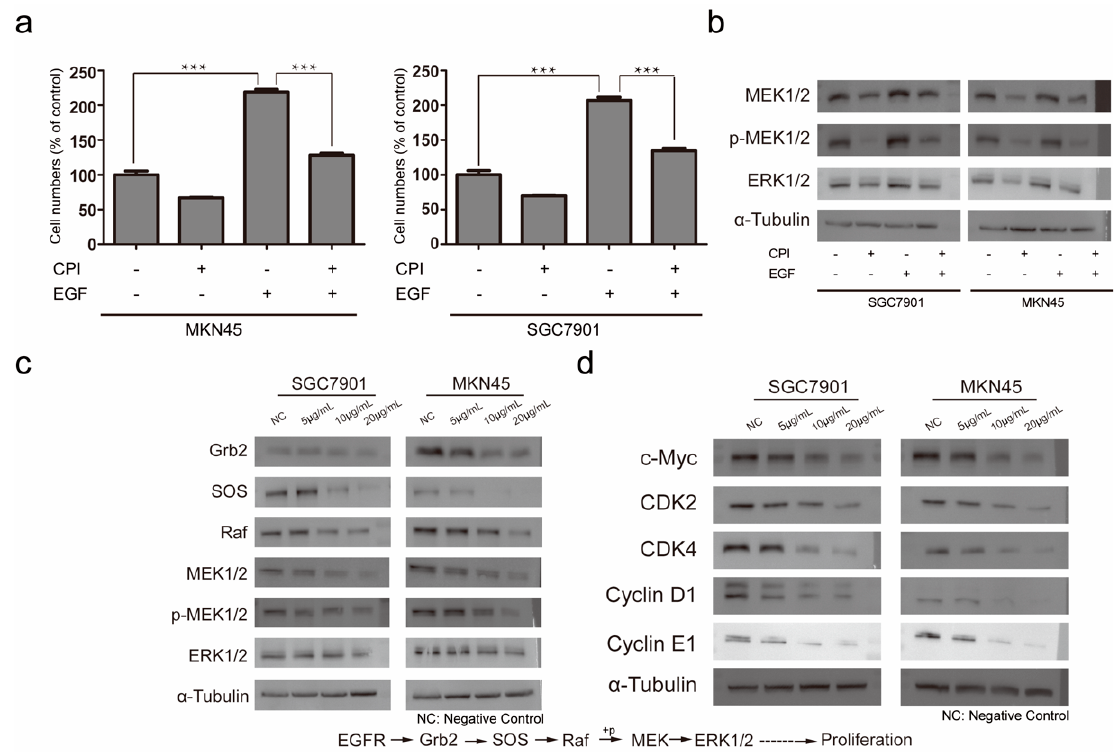
Figure 4. Exploration of the molecular mechanism of recombinant silkworm carboxypeptidase inhibitor protein inhibition of gastric cancer tumor proliferation. ( a ) The Bombyx mori carboxypepti- dase inhibitor slows EGF-induced gastric cancer cell proliferation. ( b ) EGF stimulates MAPK/ERK pathway protein expression. ( c ) The Bombyx mori carboxypeptidase inhibitor affects MAPK/ERK pathway protein expression. ( d ) The Bombyx mori carboxypeptidase inhibitor affects the expression of c-Myc and its related cyclins. The differences between the experimental and the control groups were analyzed by the Student’s t test, *** p < 0.001.